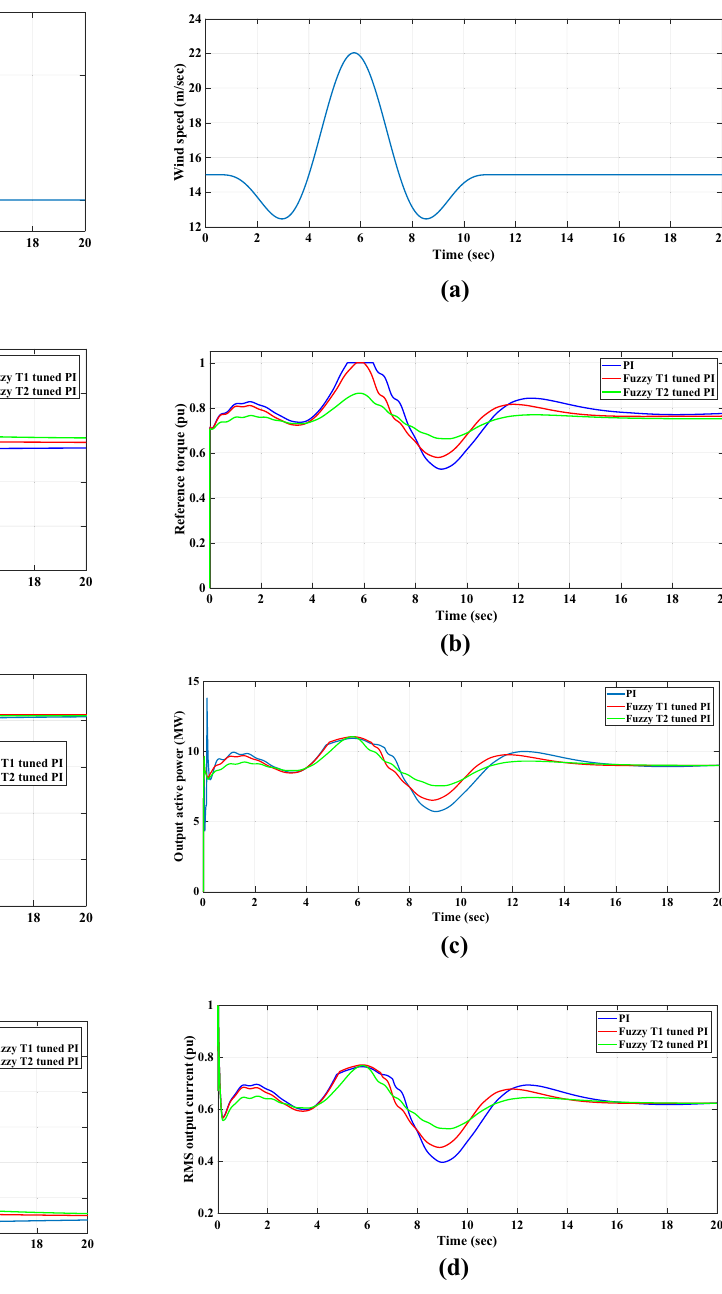
Fig. 11 Extreme change a wind speed, b reference torque, c output active power, d output